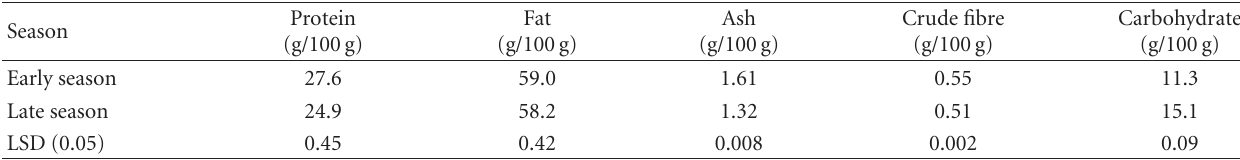
Table 2: Proximate composition of Pumpkin seeds as a ff ected by